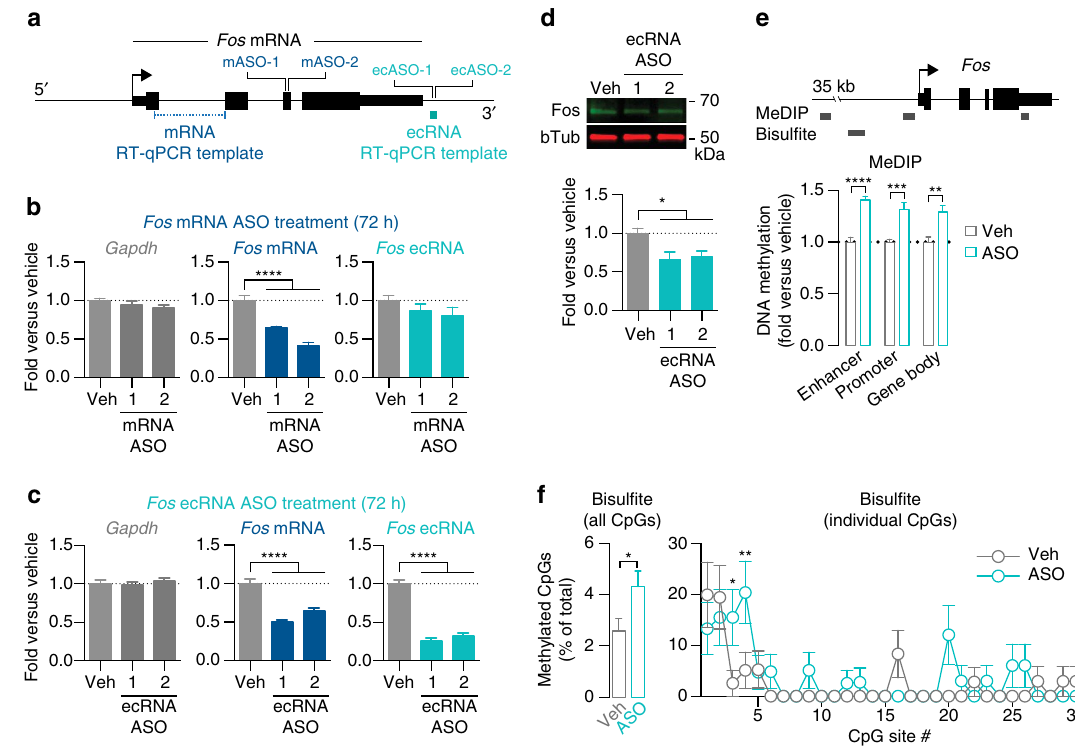
Figure 6 | Fos ecRNA controls Fos gene methylation. ( a ) Anti-sense oligonucleotide (ASO) target locations for Fos mRNA and ecRNA. ( b ) Fos mRNA ASOs decreased mRNA expression with no significant effect on ecRNA ( n ¼ 8 per group; one-way ANOVA for Fos mRNA, F (2,21) ¼ 42.96, P o 0.0001; Tukey’s post hoc test for individual comparisons.). ( c ) Fos ecRNA ASOs decreased both mRNA and ecRNA ( n ¼ 8 per group; one-way ANOVAs for Fos mRNA and ecRNA, F (2,21) ¼ 36.43 and 95.48, respectively, P o 0.0001; Tukey’s post hoc test for individual comparisons). ( d ) Fos ecRNA knockdown reduces Fos protein quantified by immunoblotting ( n ¼ 6 per group; one-way ANOVA, F (2,15) ¼ 5.438, P ¼ 0.0168). ( e ) Fos ecRNA knockdown (72h ASO treatment) resulted in increased enhancer, promoter and gene body methylation as measured by MeDIP ( n ¼ 4 per group; two-way ANOVA main effect of ASO, F (1,18) ¼ 71.60, P o 0.0001, Sidak’s post hoc test for multiple comparisons). ( f ) Bisulfite sequencing following Fos ecRNA knockdown confirmed significant promoter hypermethyation (left, average of all CpG sites; 41–45 individual clones/group, w 2 test, z ¼ 2.213, P ¼ 0.0269), driven largely by specific hypermethylation at two distinct CpG sites (right; methylation status between treatment groups compared with a two-way ANOVA with Sidak’s post hoc tests adjusted for multiple comparisons at individual CpG sites). Data are expressed as mean ± s.e.m. Individual comparisons, * P o 0.05, ** P o 0.01, *** P o 0.001 and **** P o